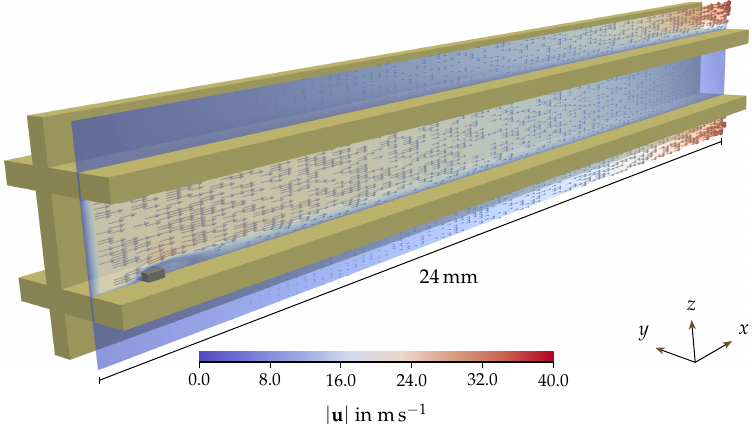
Figure 14. Flow field with an inflow velocity of ¯ u in = 20.0ms − 1 and a resolution of N = 96 featuring a single PM layer fragment in gray. Dark yellow structures represent porous filter substrate. Colour scale indicates local velocity magnitude.